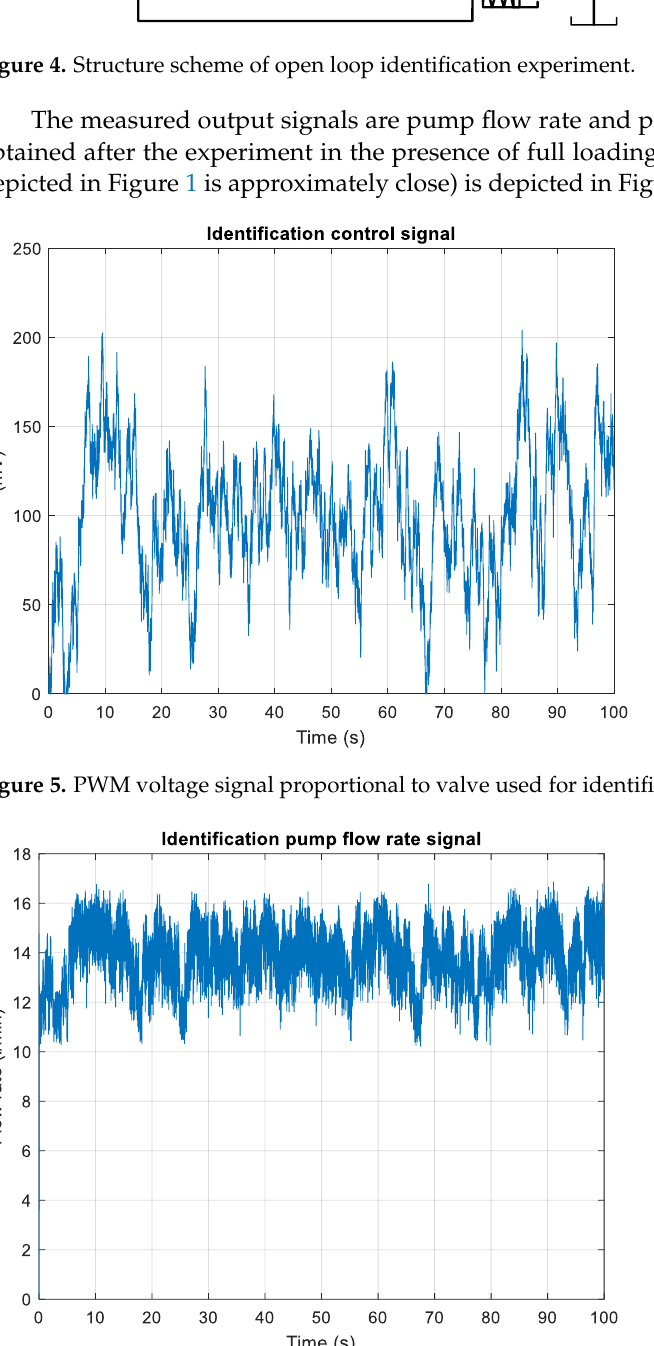
Figure 6. Pump flow rate signal used for identification experiment. Figure 5. PWM voltage signal proportional to valve used for identification experiment.